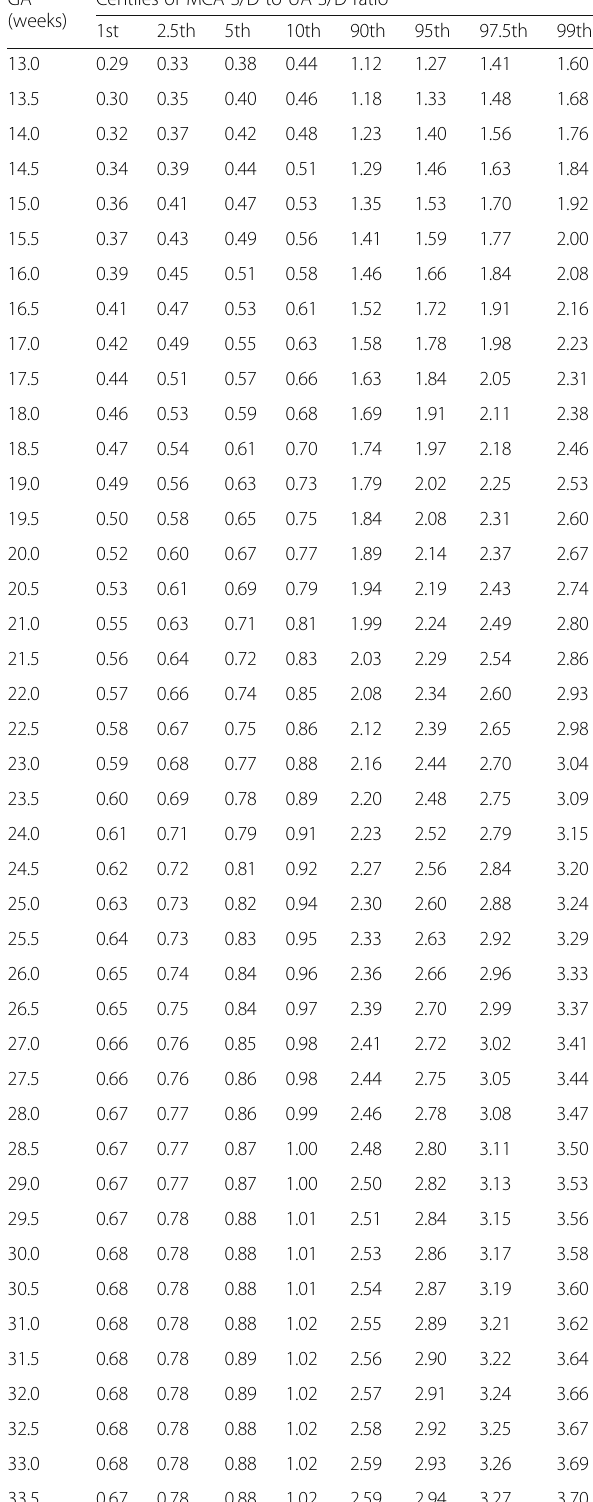
Table 3 Gestational age-defined reference ranges for MCA S/D to UA S/D ratio GA Centiles of MCA S/D to UA S/D ratio (weeks)